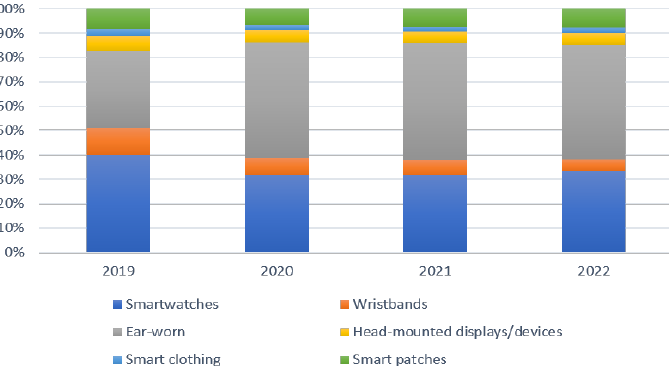
Figure 1. Consumer wearables device market share